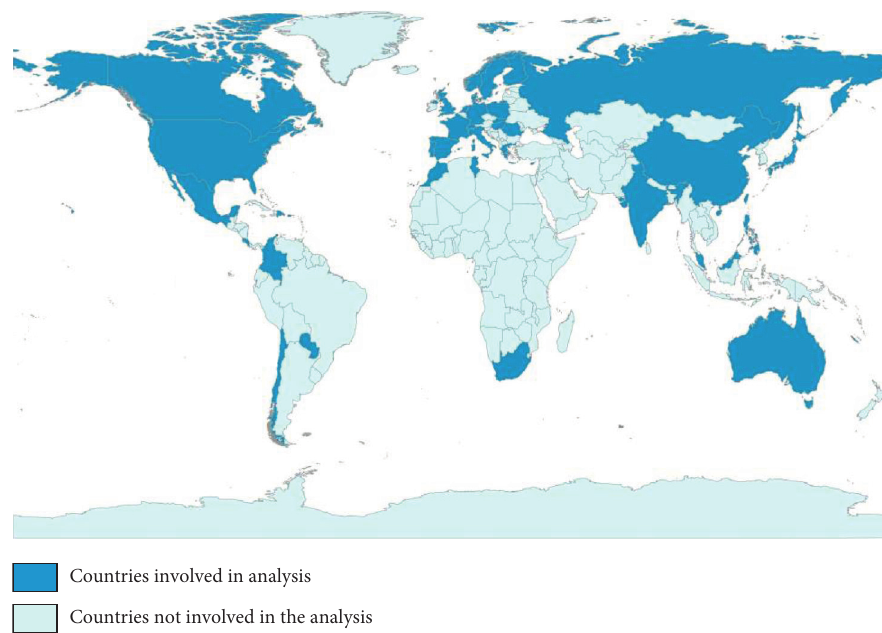
Figure 1: Geographical distribution of participating